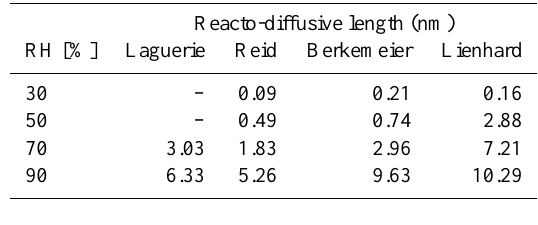
Table 1. Reacto-diffusive lengths calculated using diffusivity values obtained via the four above mentioned